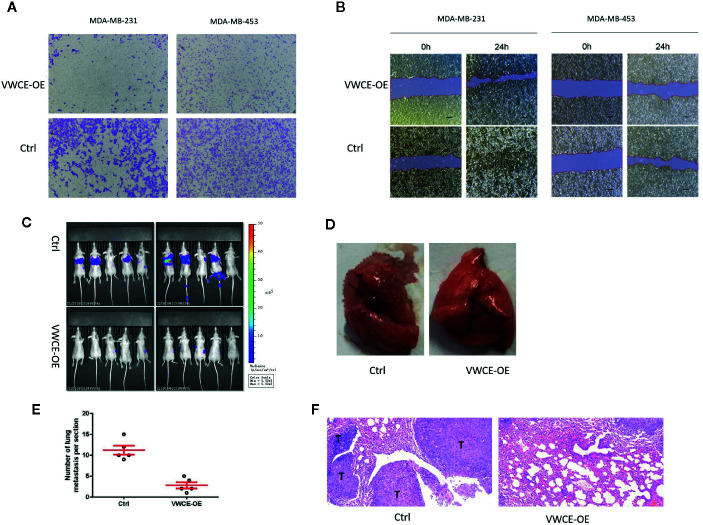
Von Willebrand factor C and EGF domain (VWCE) inhibited the cell migration of breast cancer cells. (A) The invasion ability of MDA-MB-231 and MDA-MB-453 cells infected with either the VWCE-overexpression or vector control lentivirus detected by a transwell assay (scale bar = 100 μM). (B) The impact of stably up-regulated VWCE expression on cellular invasion in MDA-MB-231 and MDA-MB-453 breast cancer cell lines by a wound healing assay. (C)
In vivo imaging of the control and the VWCE-OE group in the metastatic model was created by tail vein injection. (D) The black arrows indicate lung metastatic lesions. (E) lung metastases were counted, quantification of lung metastasis in VWCE-overexpression mice compared to contorl mice. (F) Lung tissues were photographed, ﬁxed, and stained with hematoxylin and eosin (H&E); scale bar: 100 μm.